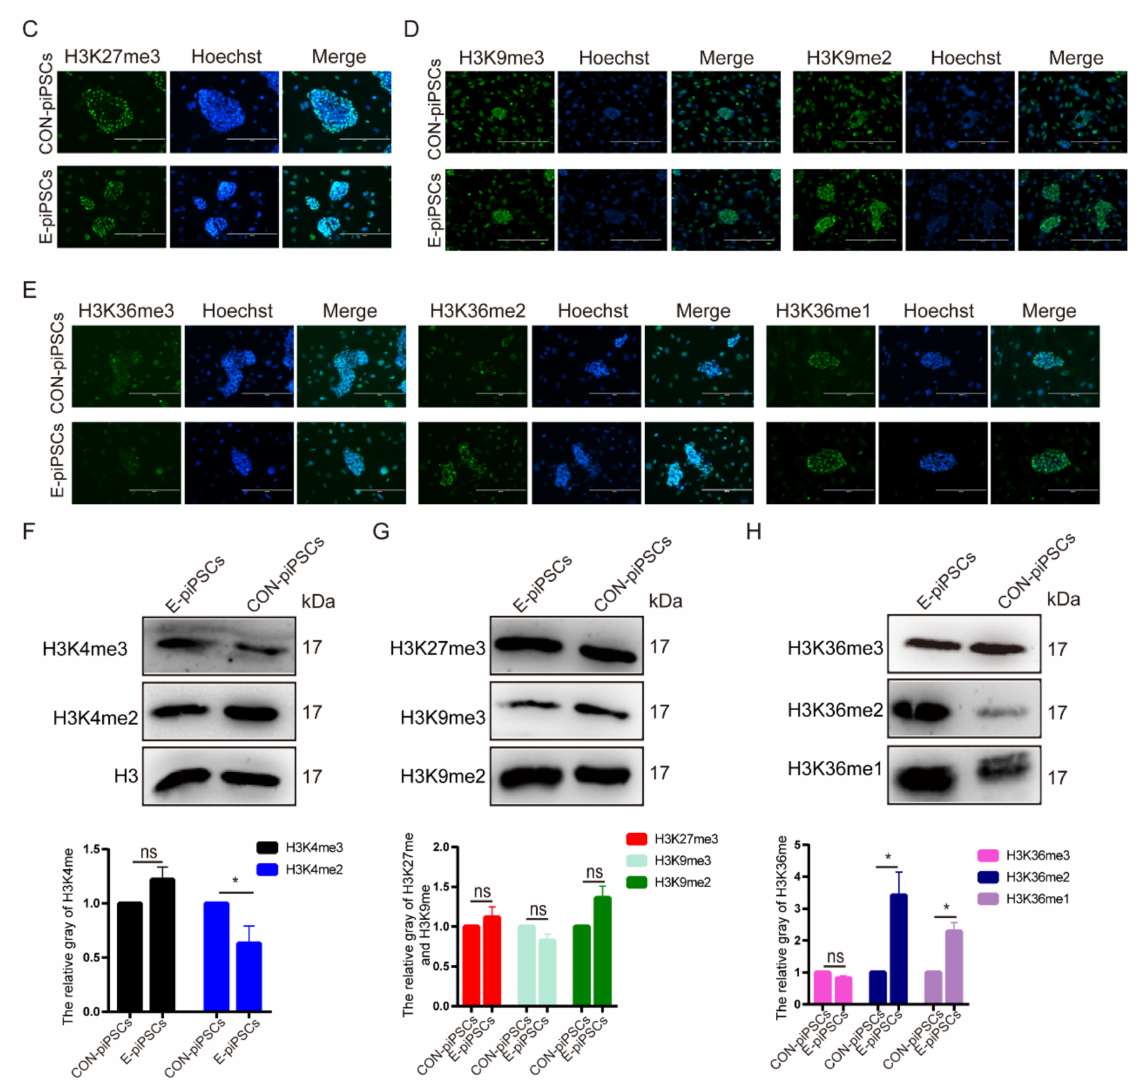
Figure 2. Characterization of the histone modifications in the CON- and E-piPSCs. ( A ) Immunofluo- rescence of the H3K4me2/3 and H3K27ac levels in the CON- and E-piPSCs; the scale bar represents 400 µ m. ( B ) Immunofluorescence of the H3K27ac levels in the CON- and E-piPSCs; the scale bar represents 400 µ m. ( C ) Immunofluorescence of the H3K9me2/3 levels in the CON- and E-piPSCs; the scale bar represents 400 µ m. ( D ) Immunofluorescence of the H3K27me3 levels in the CON- and E-piPSCs; the scale bar represents 400 µ m. ( E ) Immunofluorescence of the H3K36me1/2/3 levels in the CON- and E-piPSCs; the scale bar represents 400 µ m. ( F – H ) Western blot analysis of the H3K4me2/3, H3K9me2/3, H3K27me3 and H3K36me1/2/3 levels in the CON- and E-piPSCs. The histogram data included quantification of blots, and H3 was a loading control. ns represents p > 0.05, * represents p <